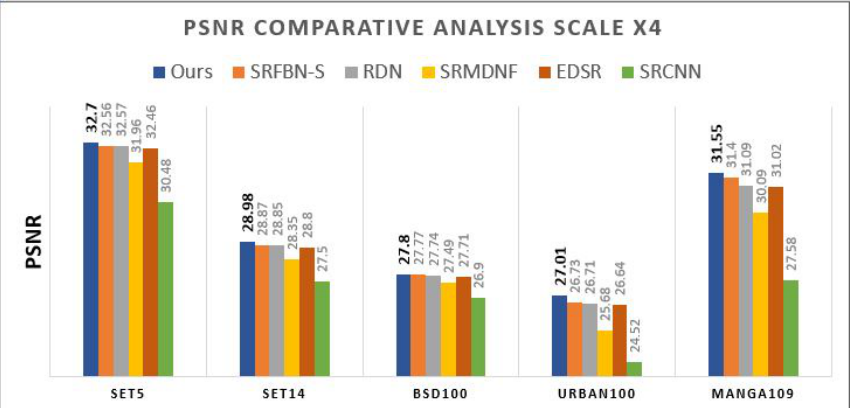
Figure 16. PSNRcomparison at × 4